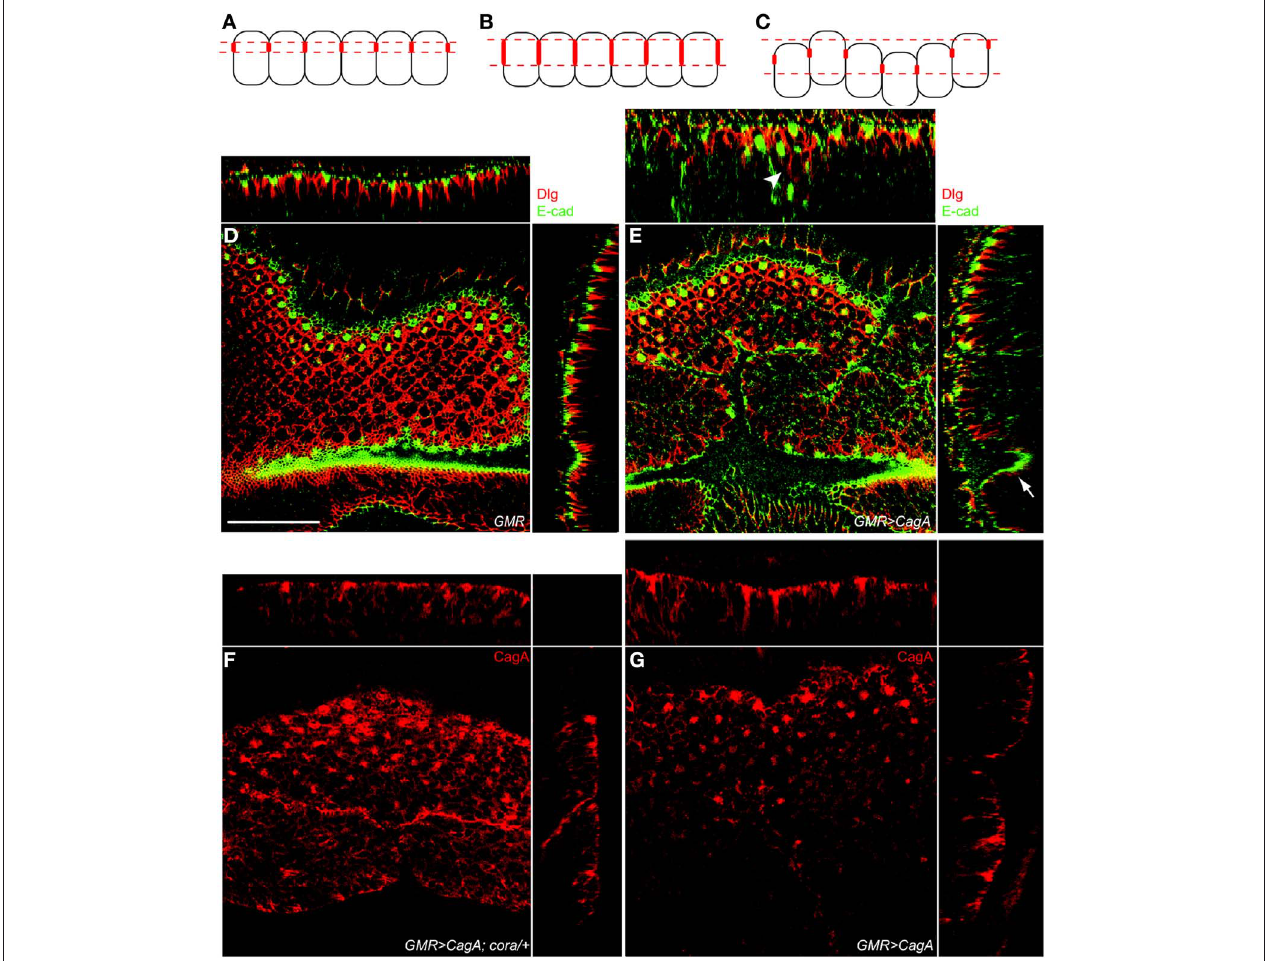
the side and top, respectively, in D and E . Scale bar is 30 microns for all panels. (E) CagA-expressing larval retinal epithelium ( GMR-Gal4; UAS-CagA ) also stained with Dlg (red) and E-cad (green). Arrowhead in the upper orthogonal section shows basally mispositioned Dlg staining. Arrow indicates Dlg staining that is deep within the epithelium due to irregularities in the epithelial sheet. (F) cora + / − larval retinal epithelium expressing CagA ( GMR-Gal4; UAS-CagA ) showing CagA localization as labeled with anti-HA. Apical HA puncta are present. (G) A larval retinal disc expressing CagA ( GMR-Gal4; UAS-CagA ) labeled with HA